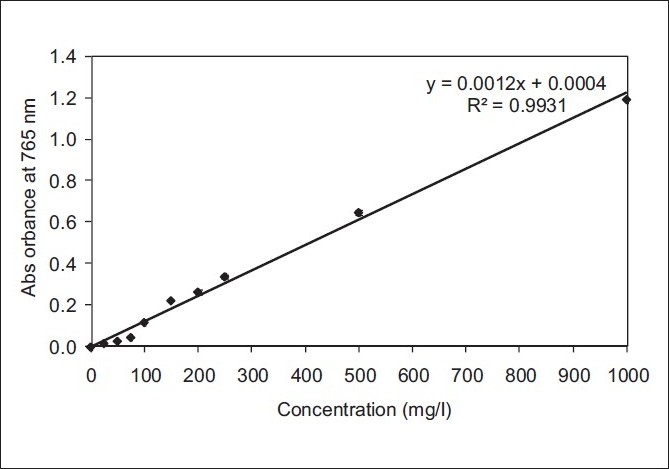
The gallic acid calibration graph